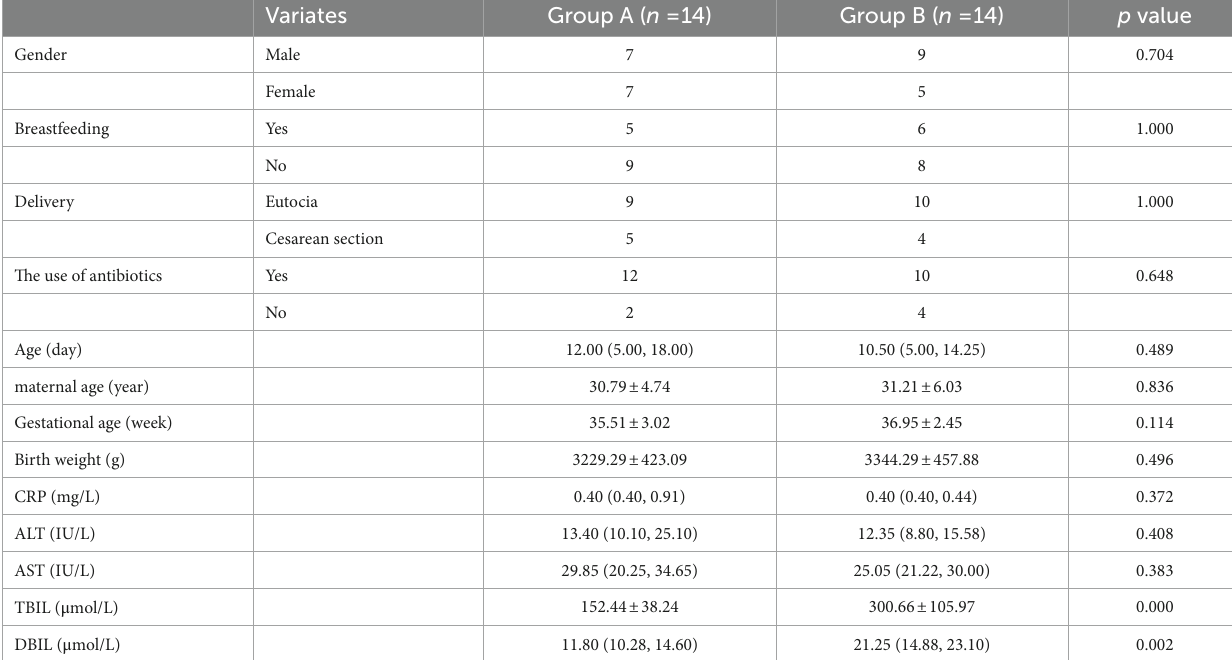
TABLE 1 Analysis of clinical